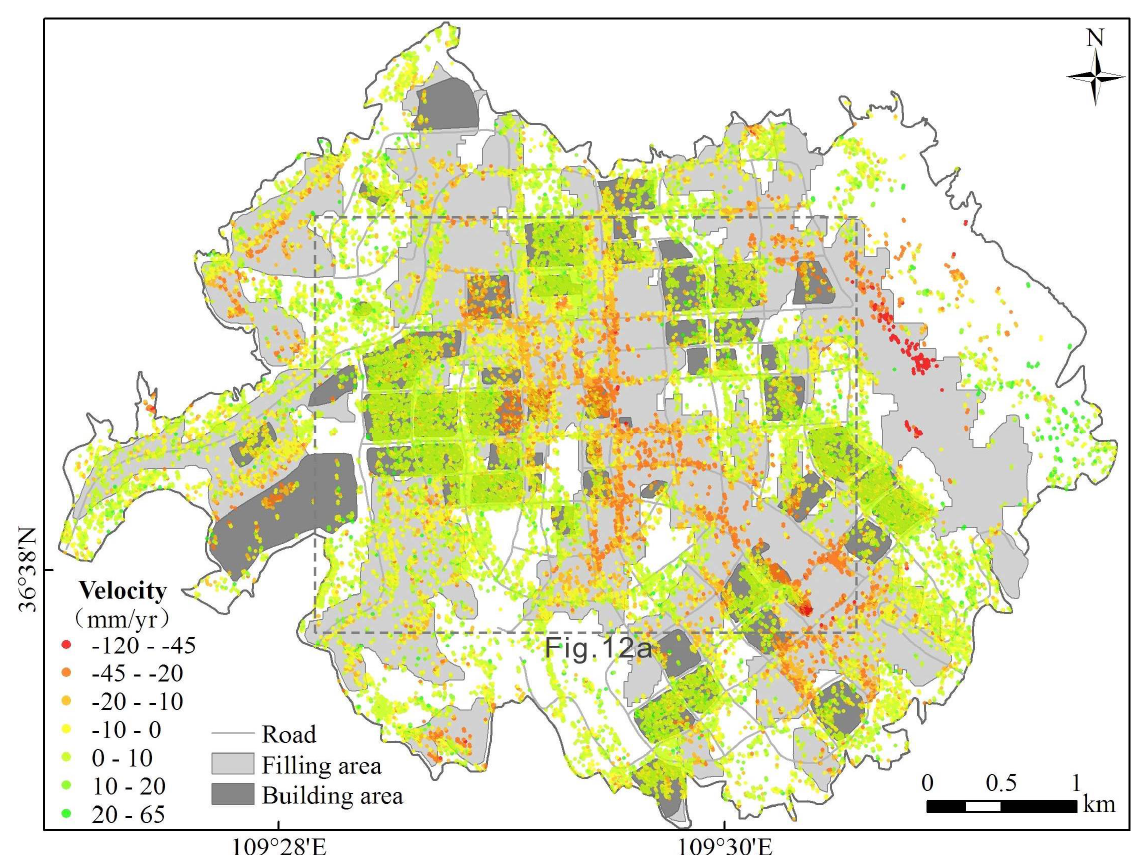
Figure 11. Land creation and urban construction in relation to the subsidence in the YND. The rectangular box is enlarged and shown in Figure 12.